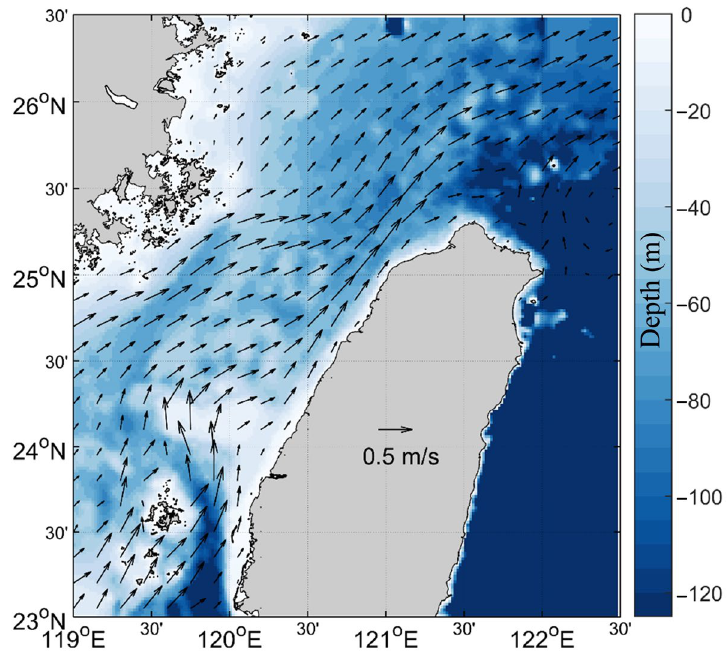
Figure 7. Average surface flow fields of the ROMS simulation in summer.